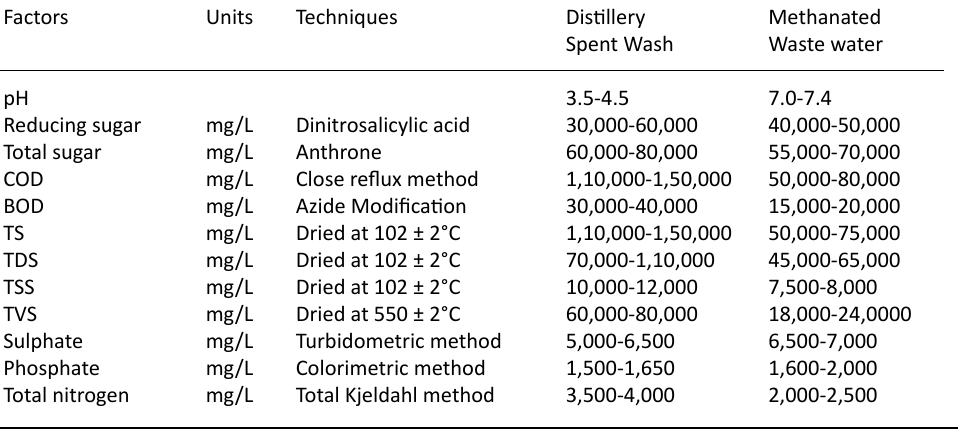
Table 1. Characteristic of Spent wash Factors Units